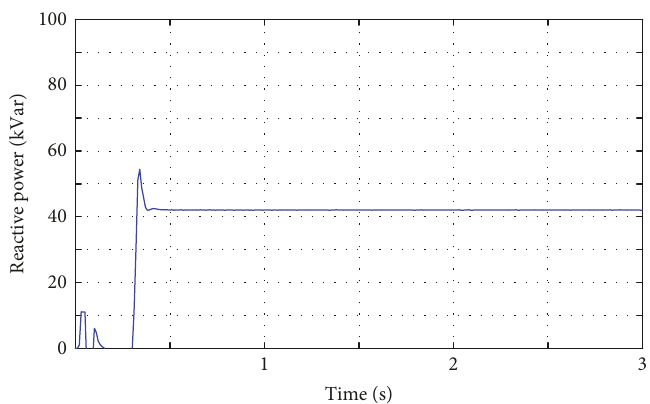
Figure 15: Reactive power injected into the grid at a 30% decrease of the bus voltage.